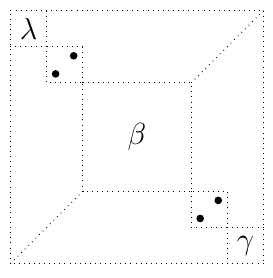
Fig. 2: Proof of Theorem 14. The special structure of a fixed point free involution avoiding 123 and with at least one succession.